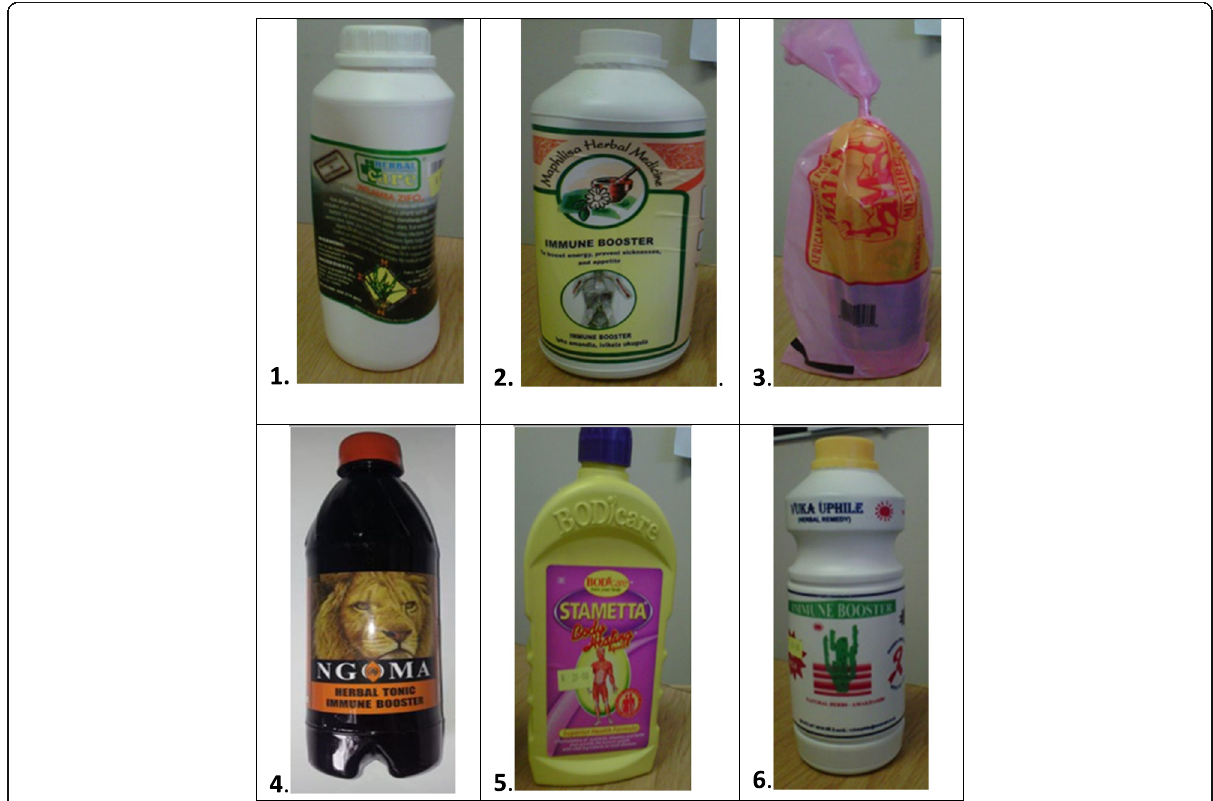
Fig. 1 The selected commercial herbal medicines. 1. Intlamba zifo ™ (HM1), 2. Maphilisa ™ Herbal Medicine (HM2), 3. Matla ™ African medicine for all diseases (HM3), 4. Ngoma ™ Herbal Tonic Immune Booster (HM4), 5. Stametta ™ Body healing liquid (HM5), Vuka Uphile ™ Herbal remedy